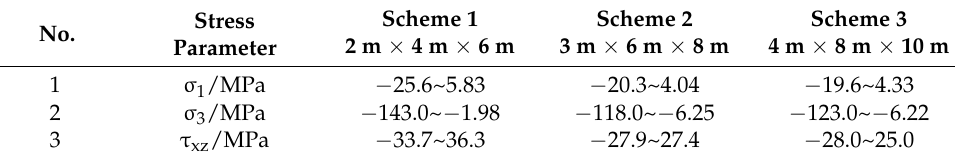
Table 4. Numerical calculation with stope height of 2.5 m.